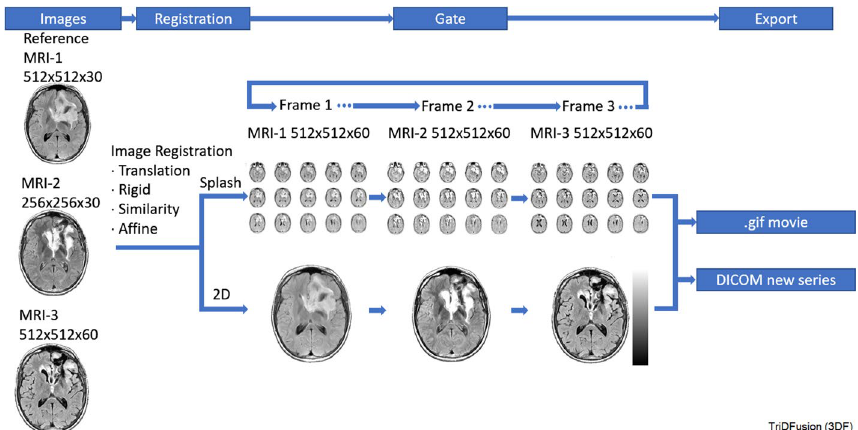
Fig. 5 Image registration workflow to create a flipbook using three separate magnetic resonance images (MRIs)